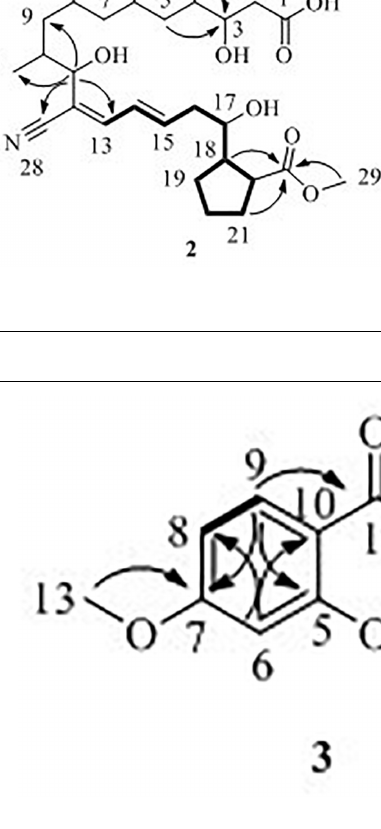
FIGURE 5 | 1 H– 1 H COSY ( — ), key HMBC ( (cid:121) ) correlations of compound 3